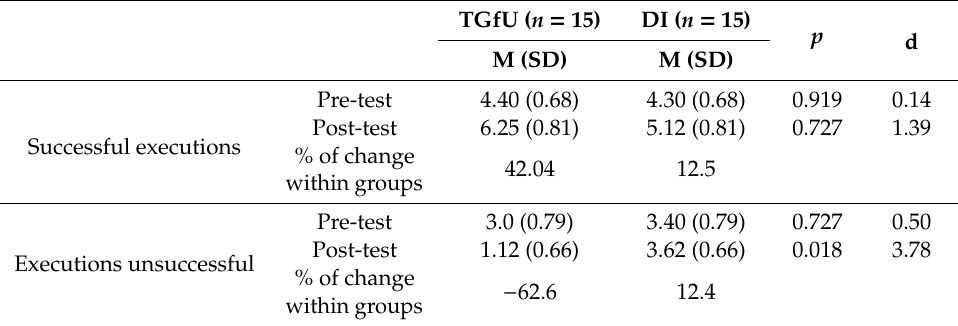
Table 5. Game Performance Evaluation Tool analysis of the attacking player with the ball according to pedagogical the approach (Teaching Games for Understanding [TGfU] vs. Direct Instruction [DI]).